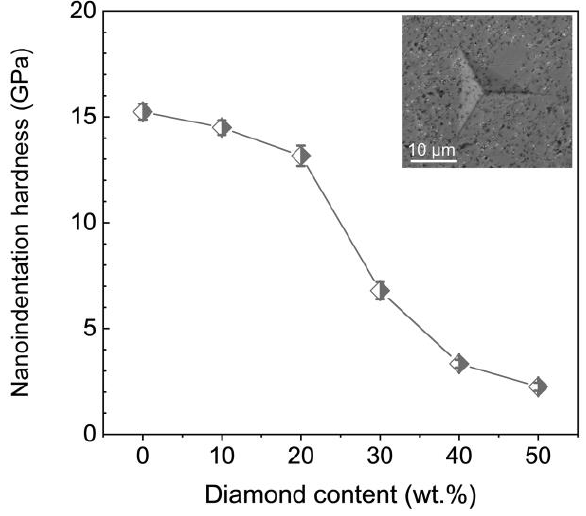
Figure 6. The nanoindentation hardness as a function with diamond content. Inset is the indentation photograph of the T-10%D sample under a load of 200 g.